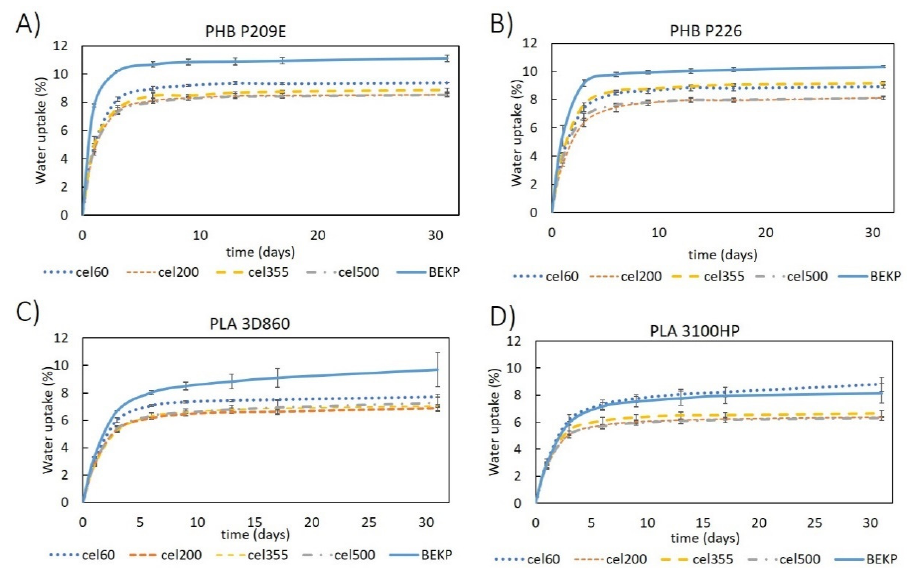
Figure 9. Water uptake as function of time for composites prepared with different micronized cellulose samples for a fiber load of 40 wt.% in matrices of: ( A ) PHB P209E; ( B ) PHB P226; ( C ) PLA 3D860 and ( D ) PLA 3100HP.